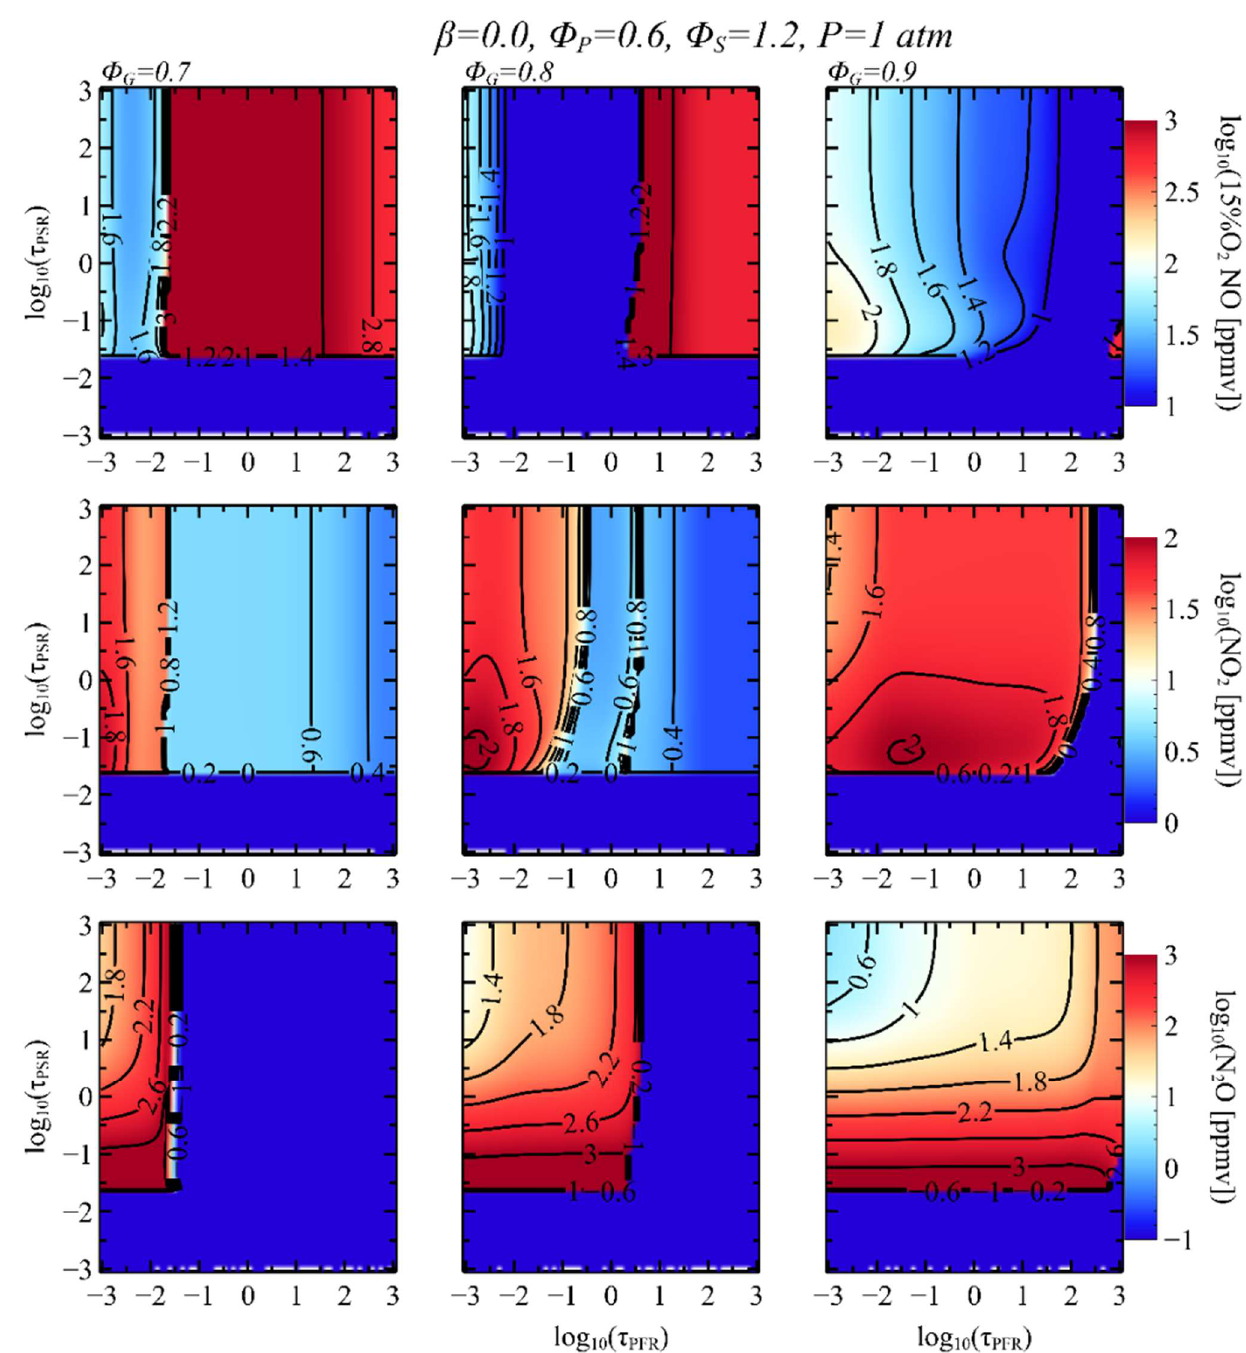
Figure 4. Contour maps of NOx emission in FS CRN. Each column represents computational results with different φ G